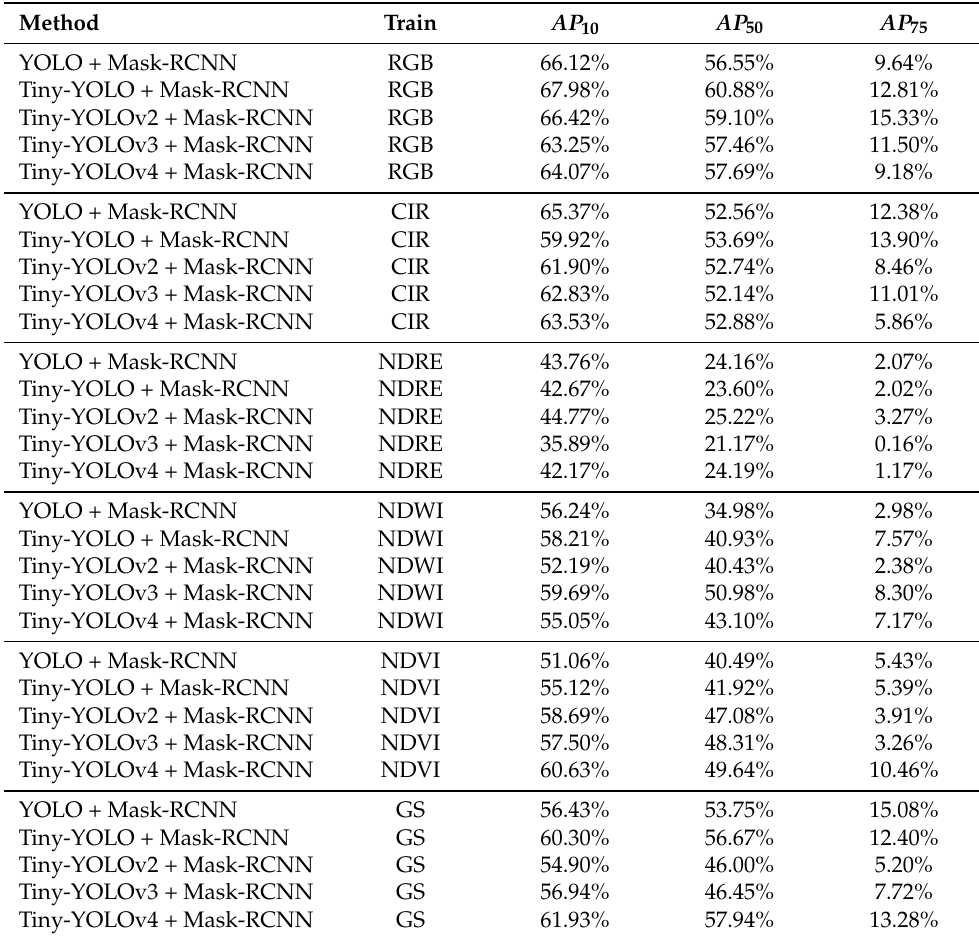
Table 5. Mask-RCNN ‘all’ layers training for 50 epochs. Method: weights used + Mask-RCNN; Train: dataset used in training; AP 10 : average precision with an IoU of 0.10; AP 50 : average precision with an IoU of 0.5; AP 75 : average precision with an IoU